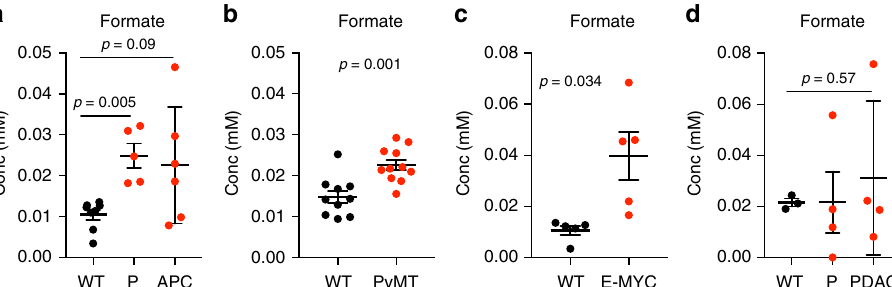
Fig. 5 Increased serum formate levels in GEMMs. a – d Serum formate in wild-type (WT), pre-neoplastic (P) and neoplastic tissues from different GEMMs for a intestinal cancer, b mammary, c lymphoma and d pancreatic ductal adenocarcinoma (PDAC). Results were obtained from at least four mice. Error bars denote s.e.m. p -values are calculated using an unpaired t -test with Welch ’ s correction